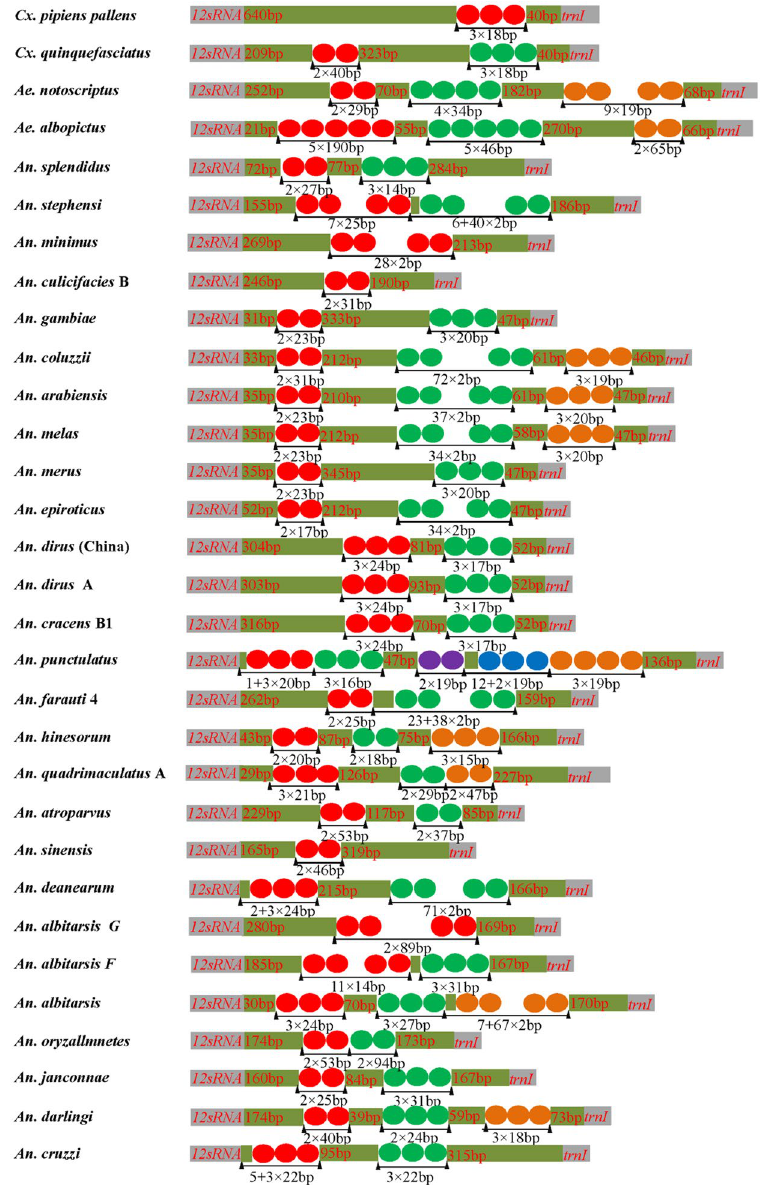
Figure 4. The structural organization of the control region of 30 fully completed mosquito mitogenomes. The location and copy number of tandem repeats are shown by colored circle. Non-repeat regions are indicated by colored box with sequence size